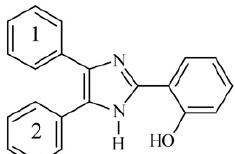
Figure 1 . Molecular structure of 4-(4,5-Diphenyl-1H- imidazo- le-2-yl) phenol